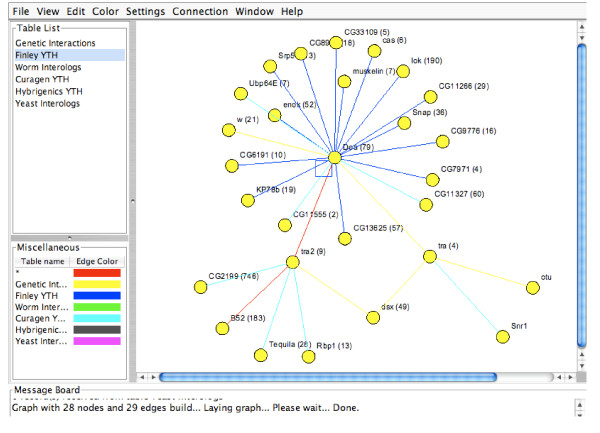
A typical IM Browser window. The panel at the left lists the interaction tables available in the database. New tables added to the database are dynamically added to the list. The main window (right) shows an interaction map with nodes (yellow circles) representing genes or proteins and edges connecting them representing interactions. The edges are colored based on the tables from which the data came, according to the key in the lower left panel; in this case, red edges indicate that the interaction is found in at least two interaction tables. The coloring scheme can be defined by the user as described in the text. Nodes and edges in the graph are both 'clickable' to obtain more information about the gene/proteins or interaction attributes from the data tables, respectively, and to link to outside databases. The graph can be manipulated manually or redrawn based on preset or user-defined parameters.